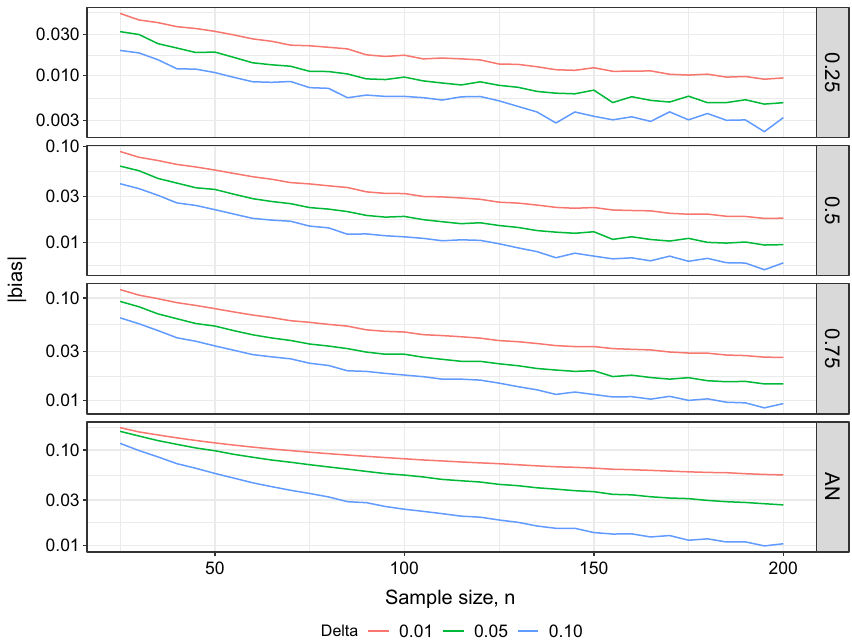
for λ 0.25 = , 0.5, and 0.75 and μ ˆ as n , the sample size, and δ , the lower Figure A2: The absolute value of the biases of μ ˆ AN λ bound on the overlap, vary in the normal model ( 18 ) . We see that bias decreases with n at roughly a n 1 / rate, as the theory suggests, and that overlap plays an important role in the bias: worse overlap consistently leads to larger